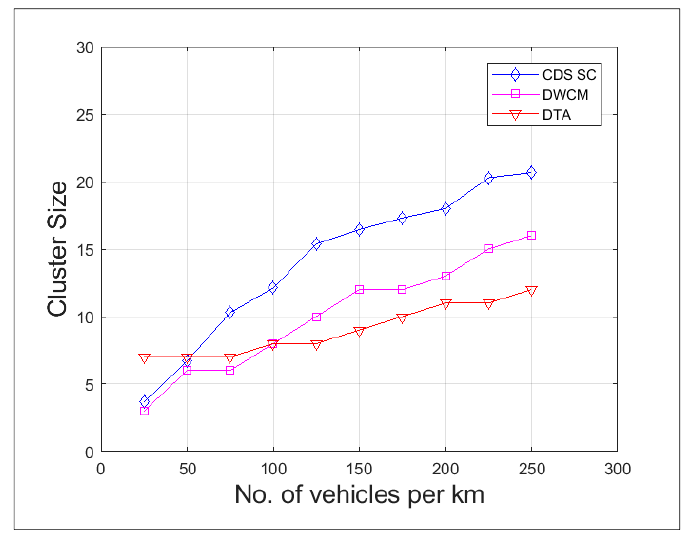
Figure 11. Average number of members per cluster.